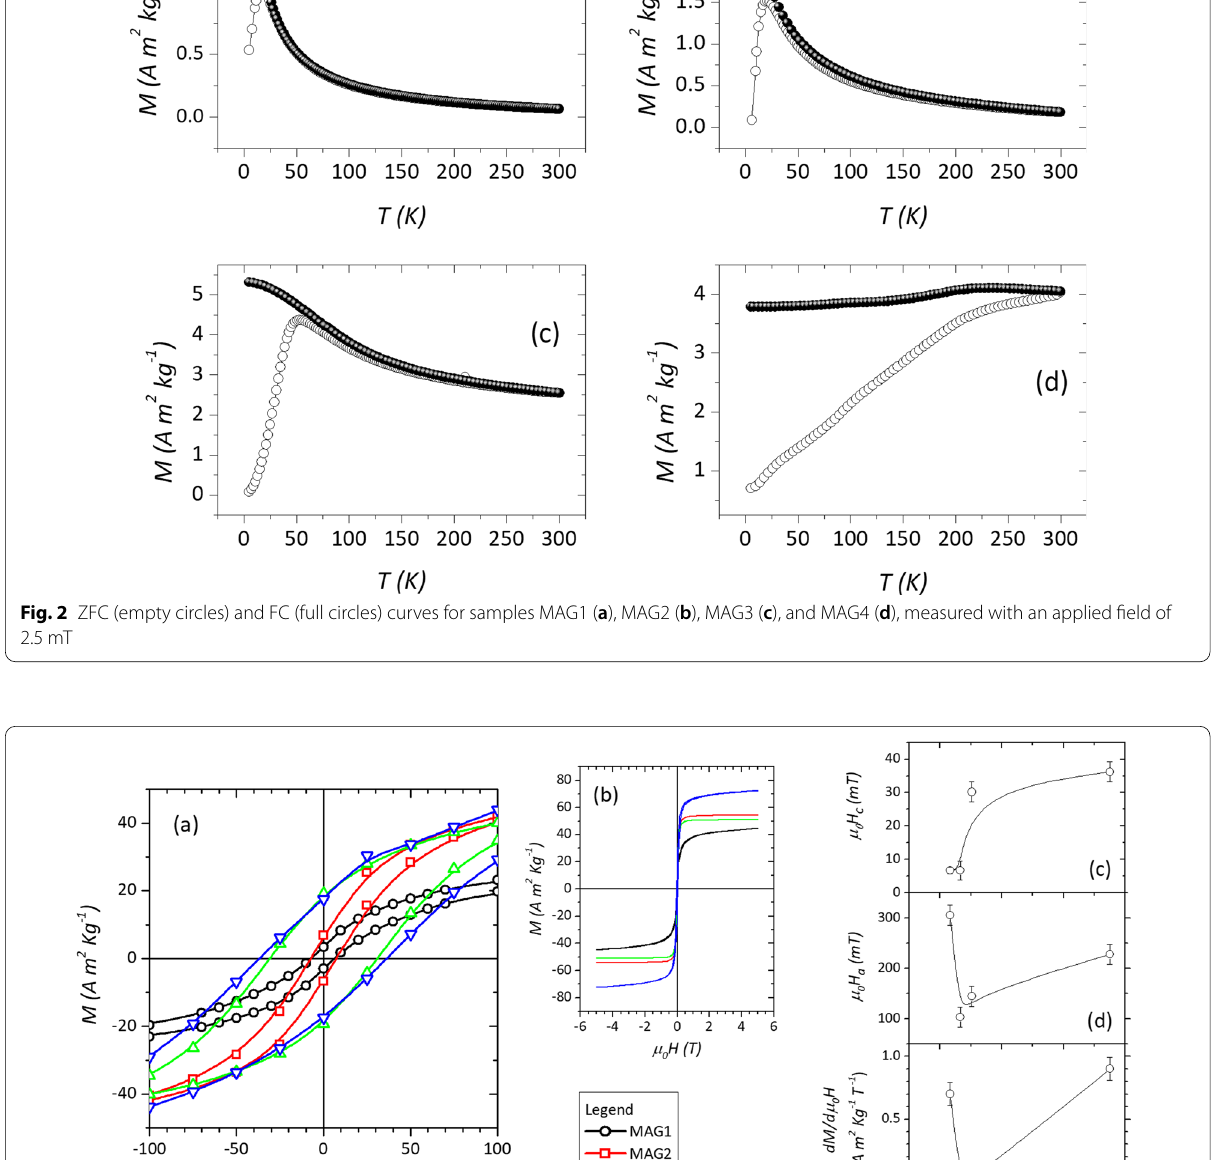
coercive field is related to the effective average anisot- ropy energy of the particles. The anisotropy field ( H a ) is the field corresponding to the merging of the up and